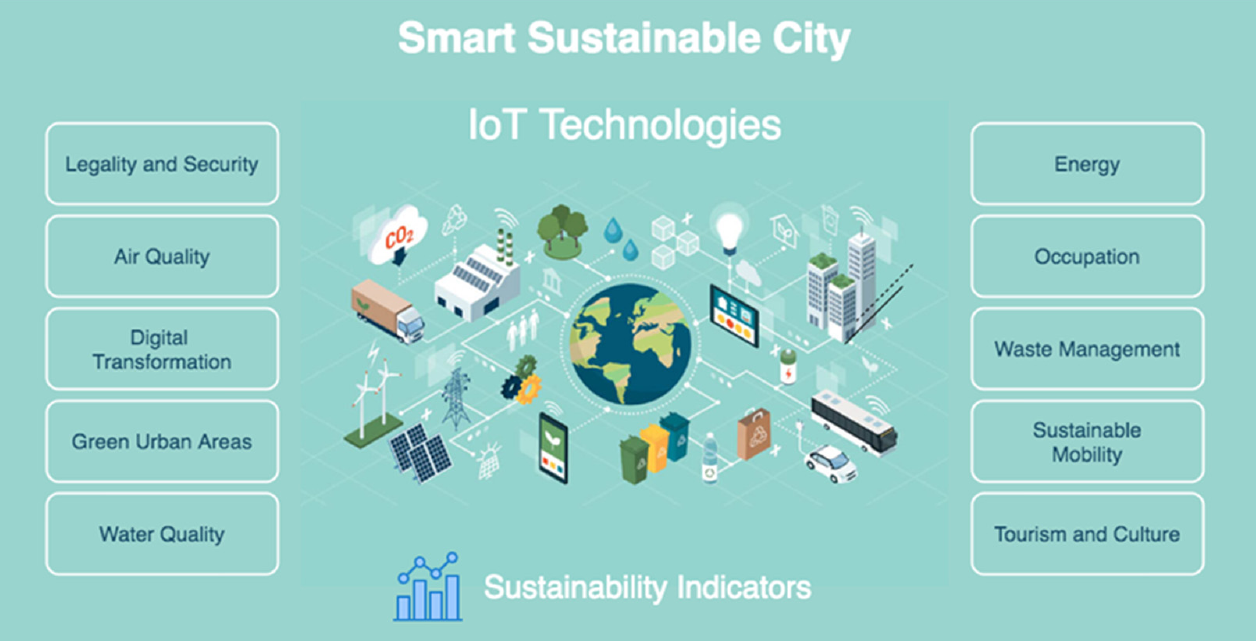
Figure 1. Major areas in smart cities that use IoT technologies, adopted from [2].